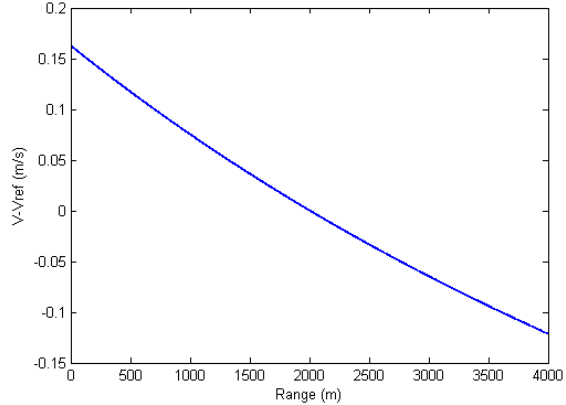
Figure 4. Velocity approximation error.